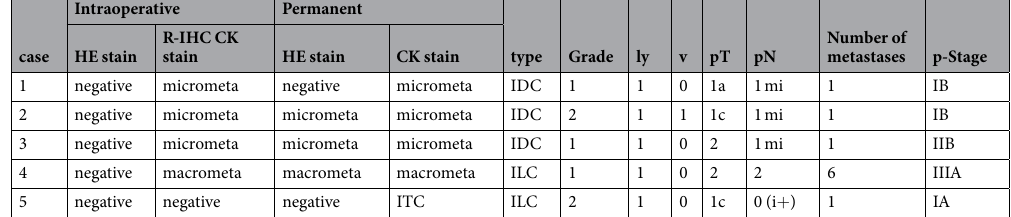
Table 4. Details of SLN diagnoses that differed between HE and CK staining.